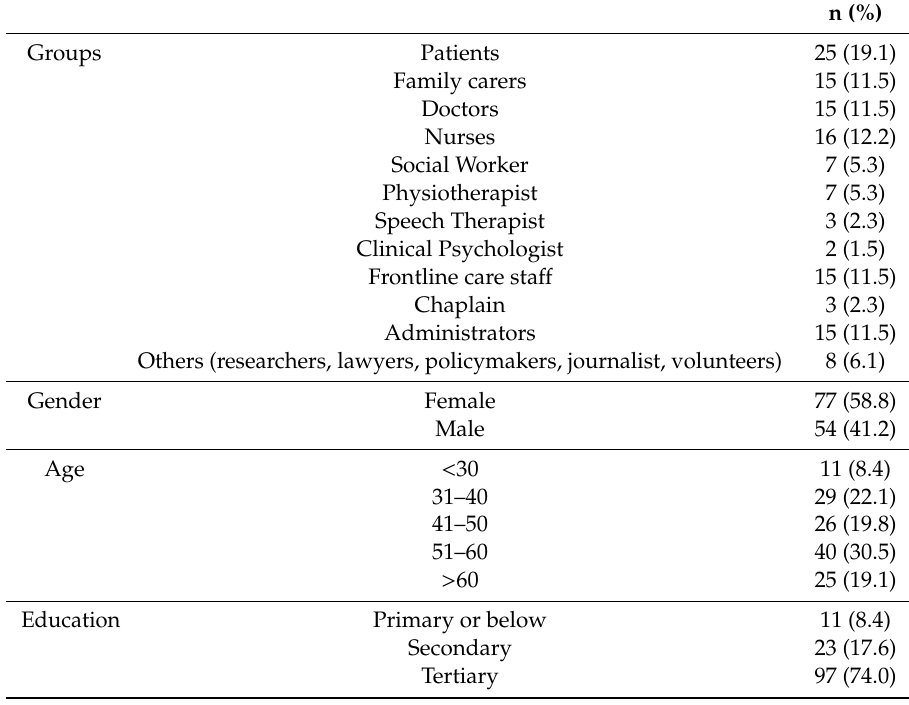
Table 1. Characteristics of participants (N =